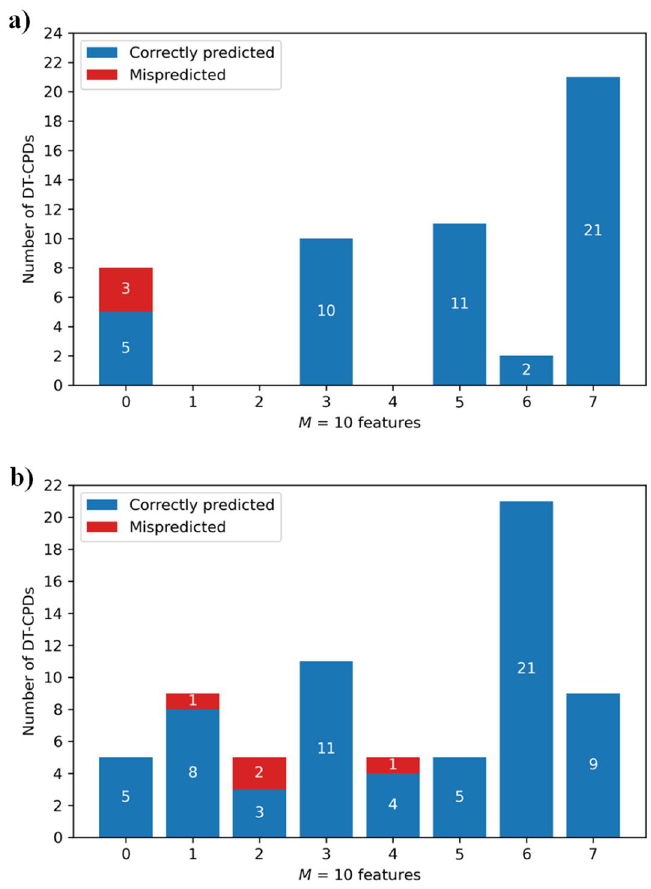
Figure 5. Distribution of prioritized features. The histogram reports the number of prioritized features in DT-CPDs for the ( a ) MAOB-A2aR and ( b ) MAOB-AChE target pair. Predictions are summarized for the two single trials reported in Table